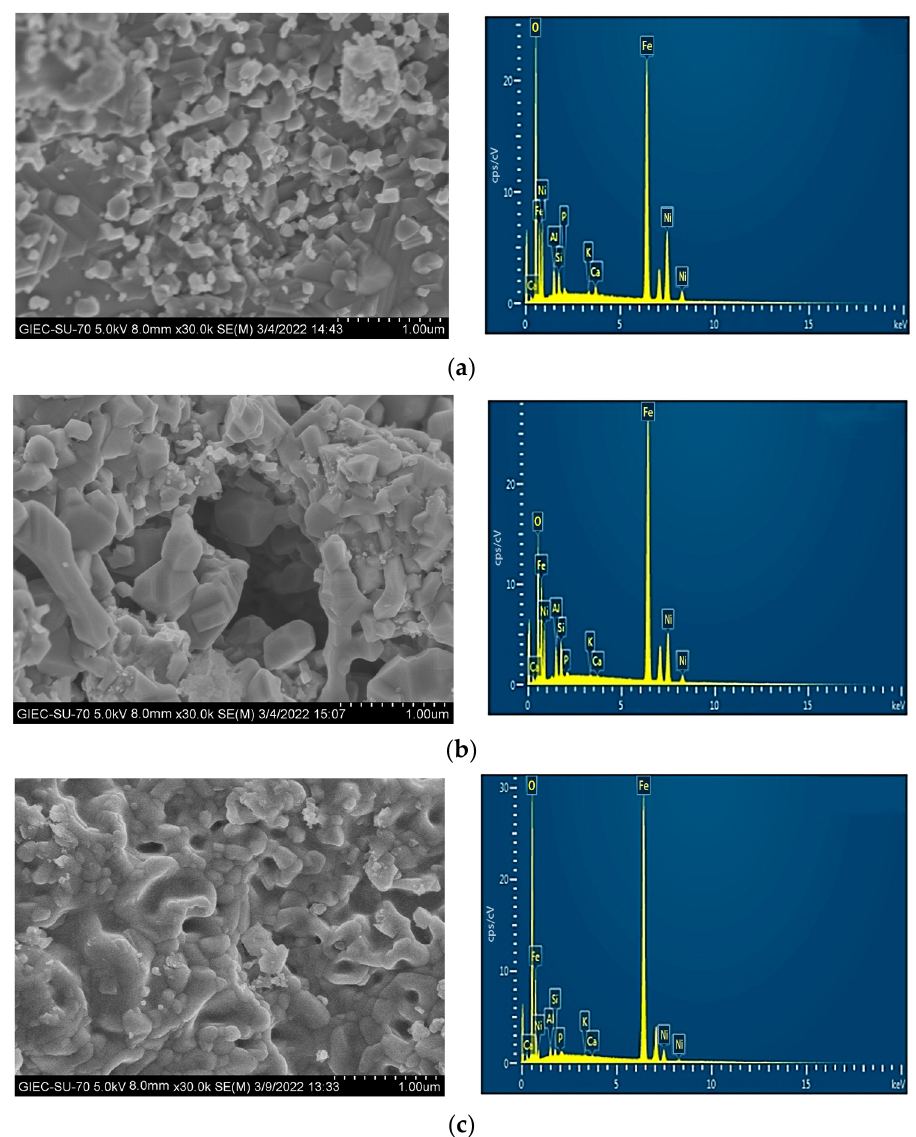
Figure 10. The SEM-EDS analysis of ( a ) the fresh OC, ( b ) the reduced OC, and ( c ) the re-oxidized OC.